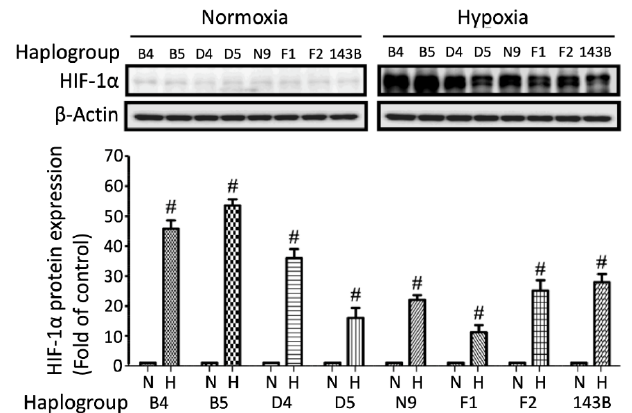
Figure 1. HIF-1 α expressions in different cybrids under hypoxia-ischemia. Comparison of HIF-1 α expression under hypoxic-ischemic conditions in cybrids harboring common mitochondrial haplogroups found in the ethnic Chinese population (B4, B5, D4, D5, F1, F2, N9). The 143B cybrid was used to represent the Caucasian population. Actin was used as a loading control. Data represent the mean ± SD of at least three independent experiments ( # p < 0.005). N was used to represent normoxic and H to represent the hypoxic condition for 24